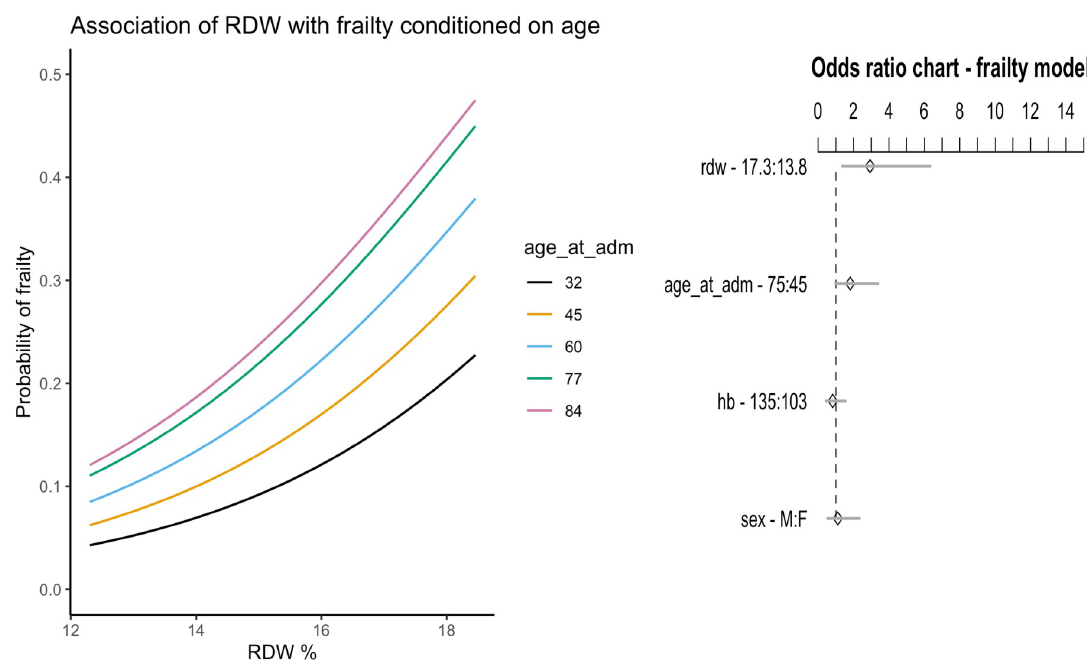
Fig 4. Frailty logistic regression model. The left-hand panel displays an estimated odds ratio (OR) chart and respective 95% confidence intervals. For example, when RDW changes from the 50 th to the 90 th percentile (13.8% to 17.3%) the odds ratio of being frail is 2.9 (95% CI 1.4–6.4). The odds for age (OR 1.8, 95% CI 1–3.4) are for the 25 th and 75 th percentile, while for haemoglobin (OR 0.8, 95% CI 0.4–1.5) they are based on the 10 th and 50 th percentile. The right-hand panel illustrates the effect of RDW on the probability of frailty for emergency laparotomy patients, estimated for different ages. The age cut-offs represent the 10 th , 25 th , 50 th , 75 th and 90 th percentile (n = 140). RDW: red cell distribution width (%), age_at_adm: age at admission (years), hb: haemoglobin (gl -1 ).